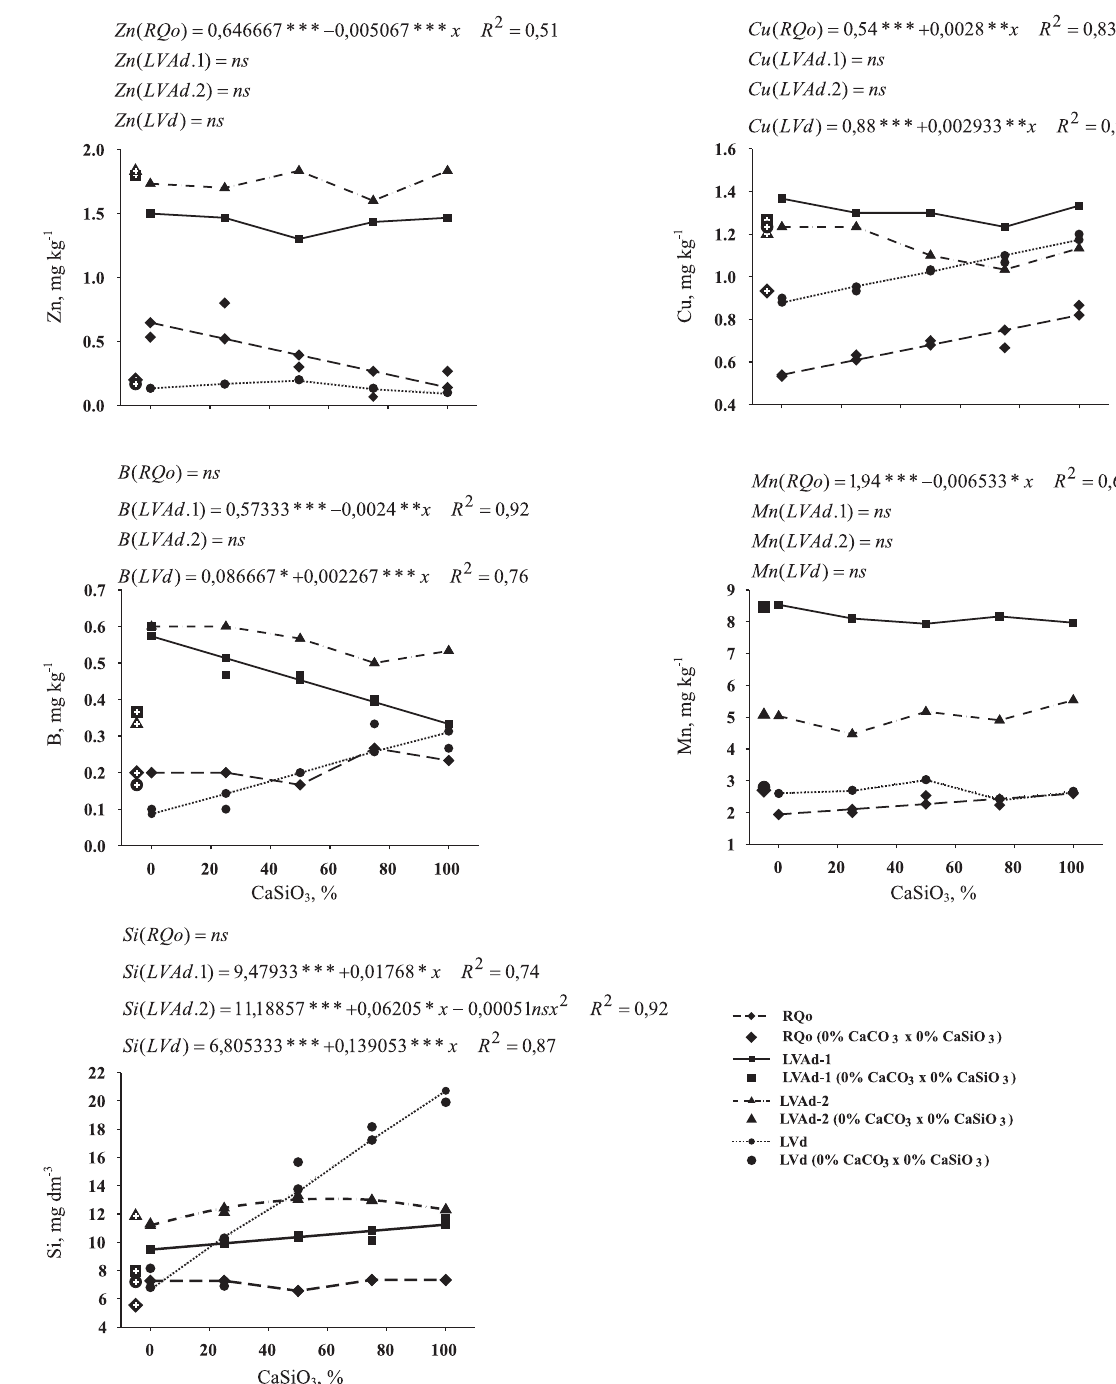
Figura 4. Influência da substituição do CaCO LVAd-1, LVAd-2 e LVd e solos sem correção. ***, **, * e ns: significativo a 0,1; 1 e 5 %, e não-significativo,